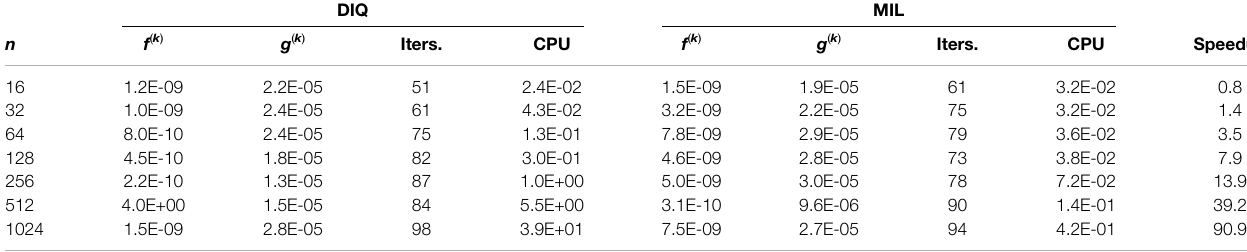
TABLE 3 | Performance comparison of DIQ vs. MIL methods testing on Rosenbrock function.